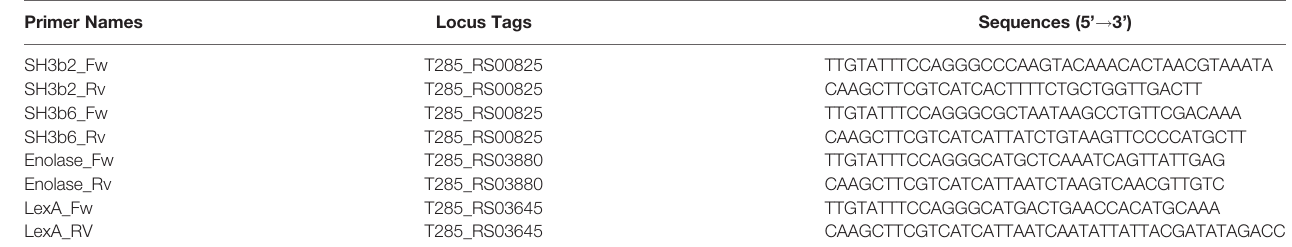
TABLE 1 | Primers used for cloning and protein puri fi